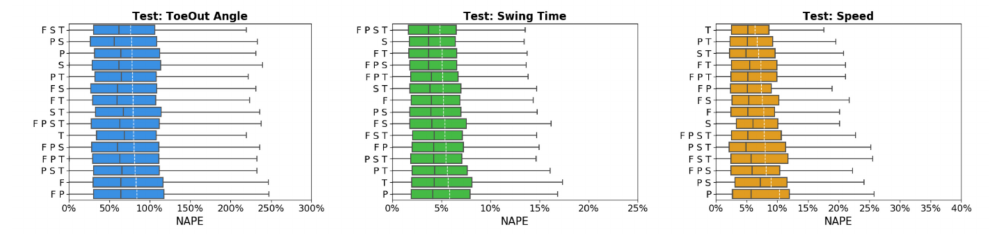
Figure 3. Normalized absolute percentage error (NAPE) of neural network for spatial (blue), temporal (green), and general (orange) gait parameters with various sensors configurations in the test set. Whiskers indicate 25% and 75% quartiles. For each gait parameter, sensor configurations are listed in order of increasing